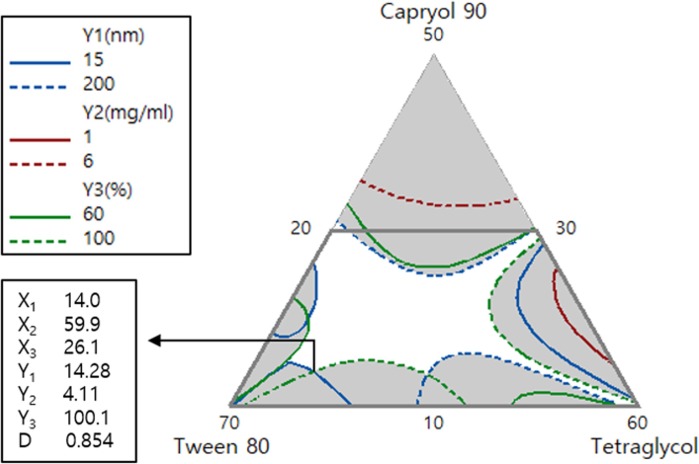
Overlay contour plot of the optimized TPC-loaded SMEDDS formulation.Upper box shows the target and limit values for optimization. Values in the lower box represent the percentage of three components and the predicted responses for the optimized formulation with a desirability value.